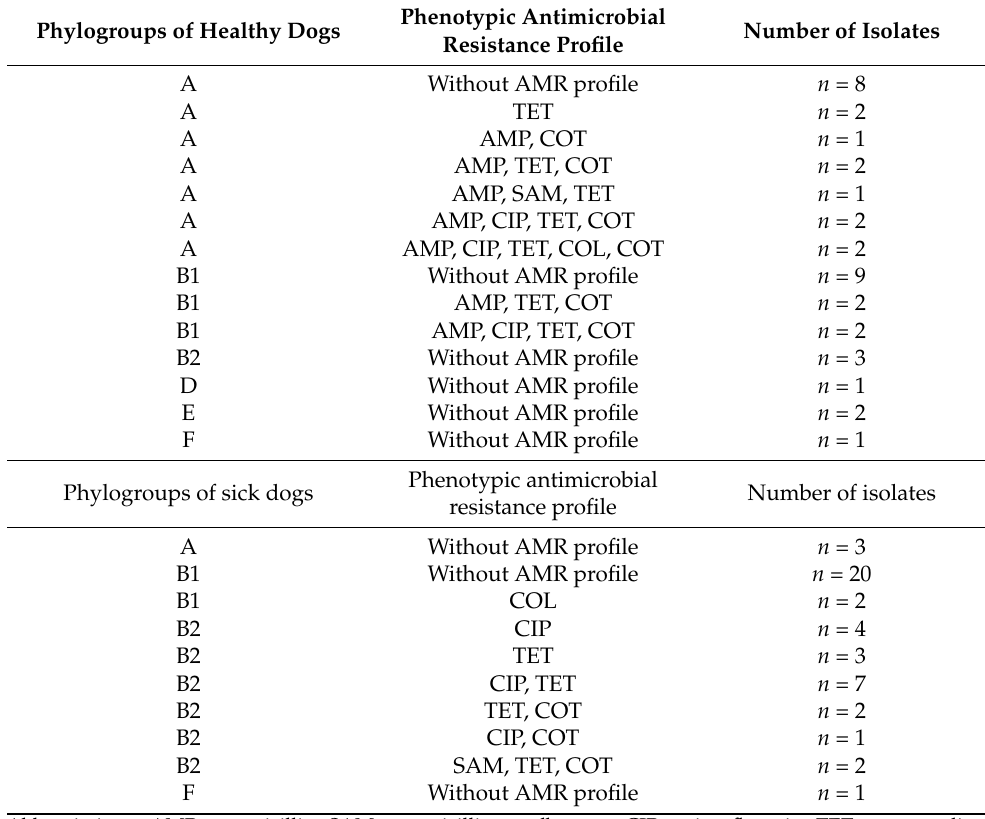
Table 2. The frequency of phenotypic antimicrobial resistance/sensitivity divided into phylogroups in healthy and sick